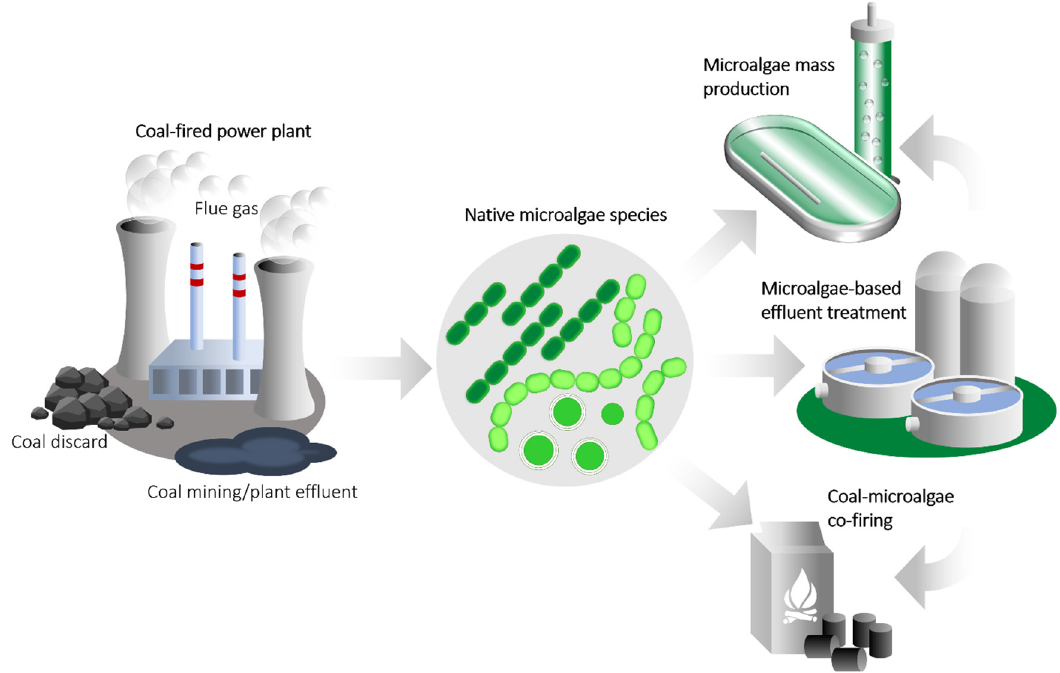
Figure 4. Native microalgae from the aquatic coal environment possess enormous biotechnological potential: they capture and sequester carbon to offset flue gas emissions from power plants, and the easily obtained microalgal biomass can be used for lipid/biofuel production. Coal mine drainage and power plant effluents can be decontaminated with microalgae. Finally, coal discards/fines can be burned with microalgae as a heat-efficient coal–microalgae composite. Microalgal bioremediation becomes even more attractive when the biomass cultivated in wastewater treatment systems is used as a feedstock.